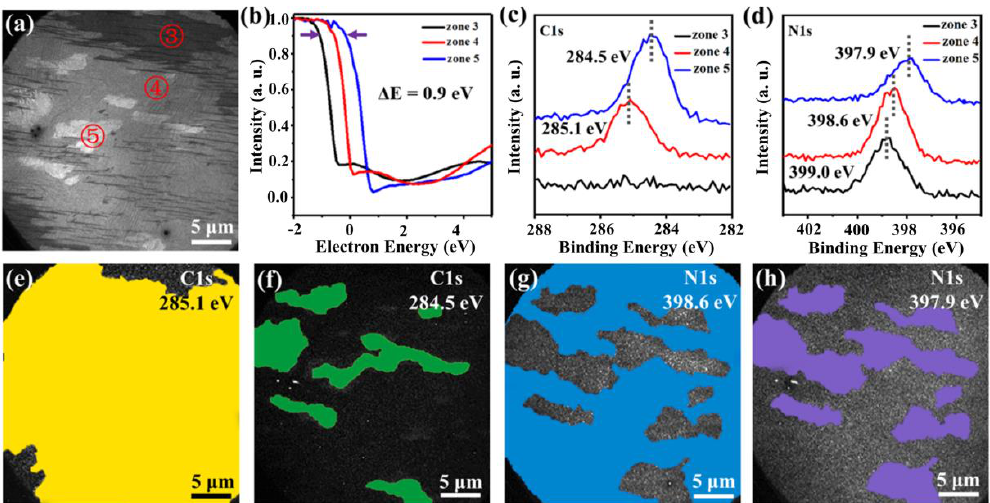
Figure 4. ( a ) LEEM image of the surfaces successively segregated at 600 ◦ C. ( b ) LEER spectra acquired from zone 3, 4, and 5, respectively. ( c ) C 1s and ( d ) N 1s core level spectra ( hv = 500 eV) measured on zone 3, 4 and 5, respectively. ( e – h ) XPEEM images at C 1s core levels with binding energies of 285.1 and 284.5 eV, and N 1s core levels with binding energies of 398.6 and 397.9 eV, respectively. The distribution of related elements with the certain chemical state is color-coded and the black contrast represents background signals, and those initial data are shown in Figure S2 in the supplementary materials.